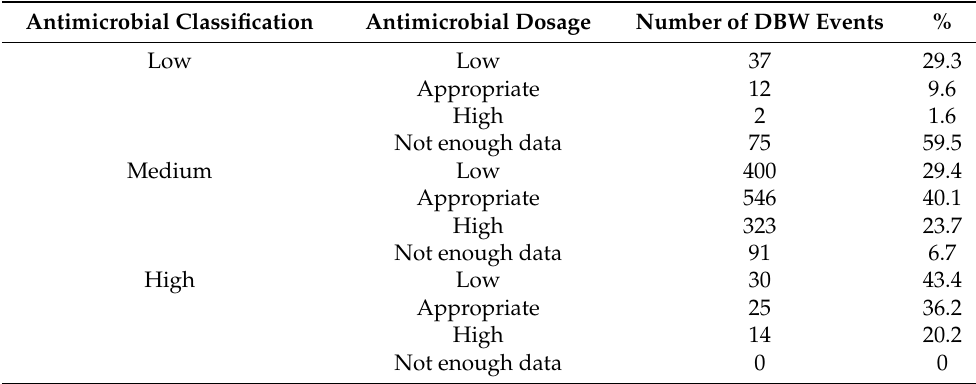
Table 4. Antimicrobial dosage [10,11] for each class of antimicrobial importance prescribed to dogs that presented for treatment of dog-to-dog bite wounds from 1998 to